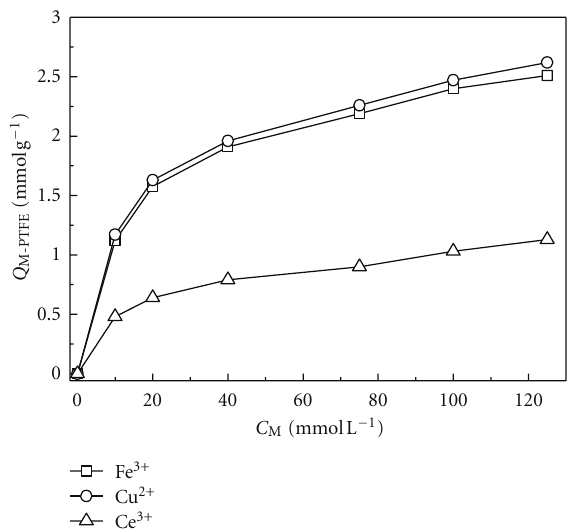
Figure 2: E ff ect of C M on Q M-PTFE of the complexes during the